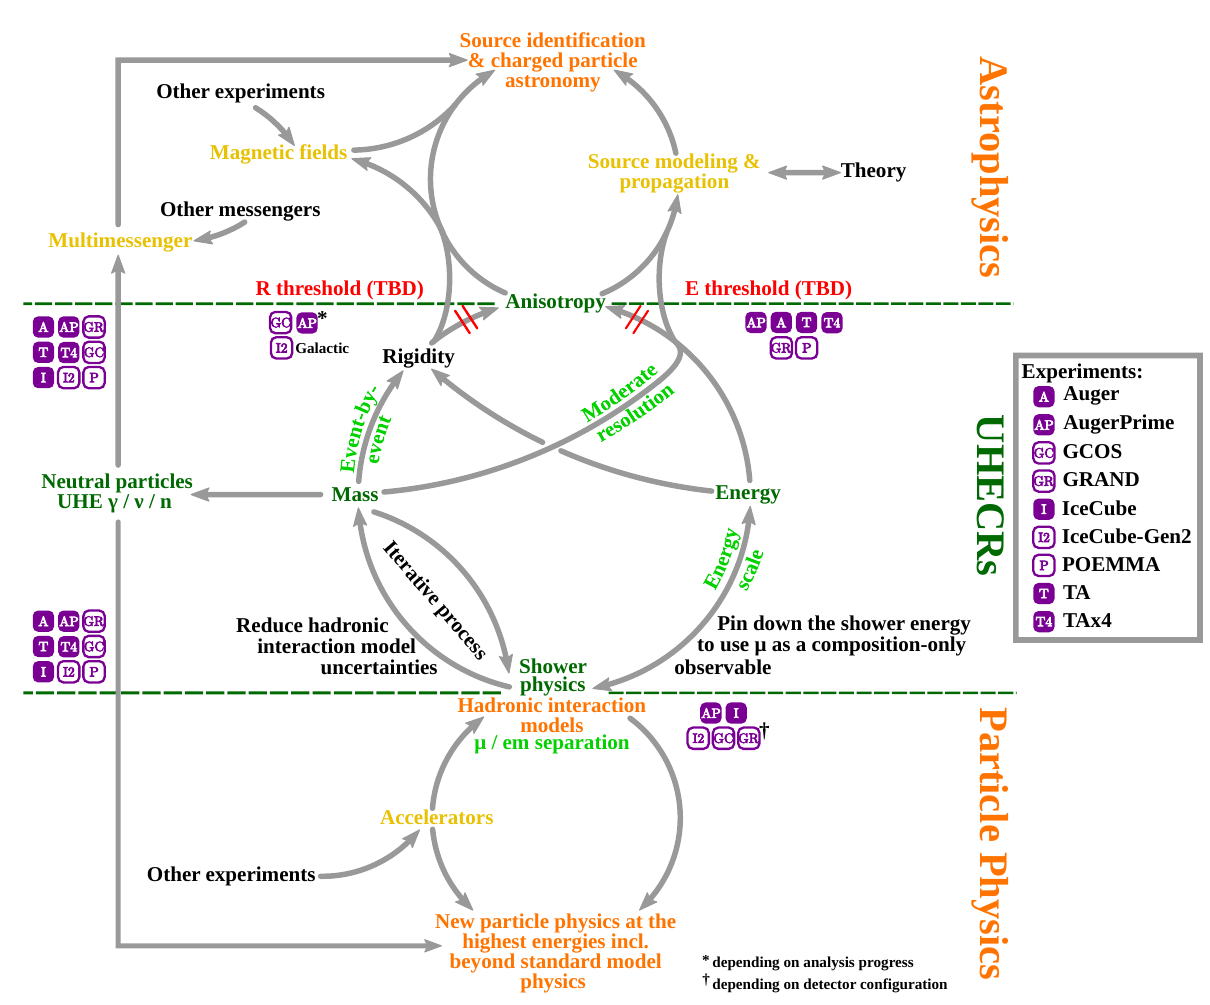
*depending on analysis progress †depending on detector configuration Figure 1. Sketch of how ultra-high-energy cosmic rays (UHECRs) are related to astrophysics and particle physics, and how current and future experiments contribute to each of these areas of physics. The mass and energy of the primary UHECRs are derived from air-shower measurements. These air-shower measurements are also used to study hadronic interactions and complement accelerator experiments, particularly in the forward region. Improvements of hadronic interaction models, in turn, will increase the accuracy of the mass derived from the measured air showers. Depending on the mass resolution, the astrophysics question of the UHECR sources is targeted either by rigidity-enhanced anisotropy measurements, which potentially enables particle astronomy by back-tracking through the magnetic fields in space, or by statistically comparing source models to measured anisotropy and mass composition. Finally, the search for neutral EeV particles, such as photons and neutrinos, enables a multi-messenger access to the UHECR sources and o ff ers discovery potential for new particle physics beyond the standard model. (Figure from Ref.